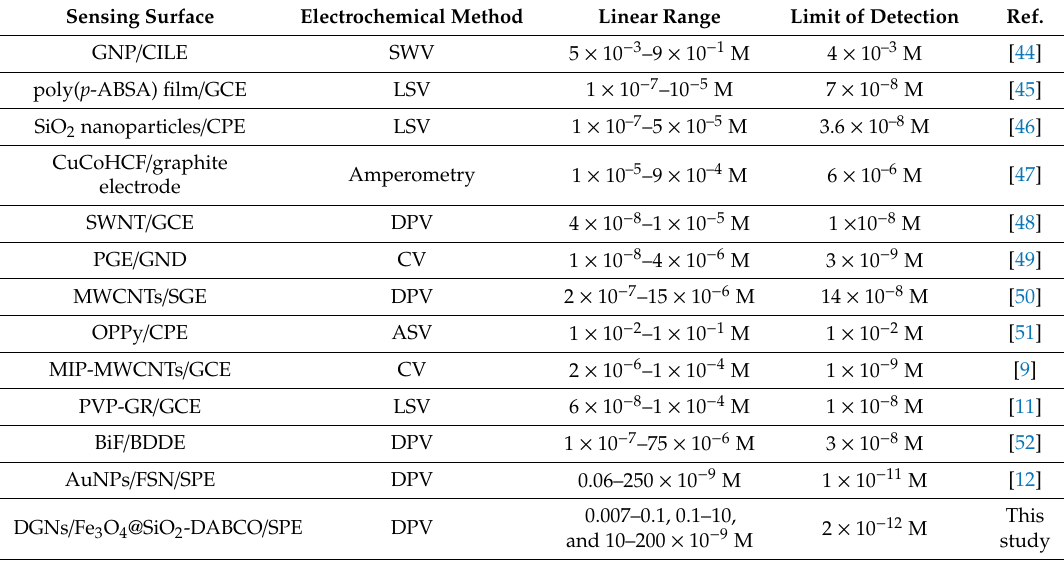
Table 1. Comparison of the analytical performance between the proposed aptasensor and other detection methods for